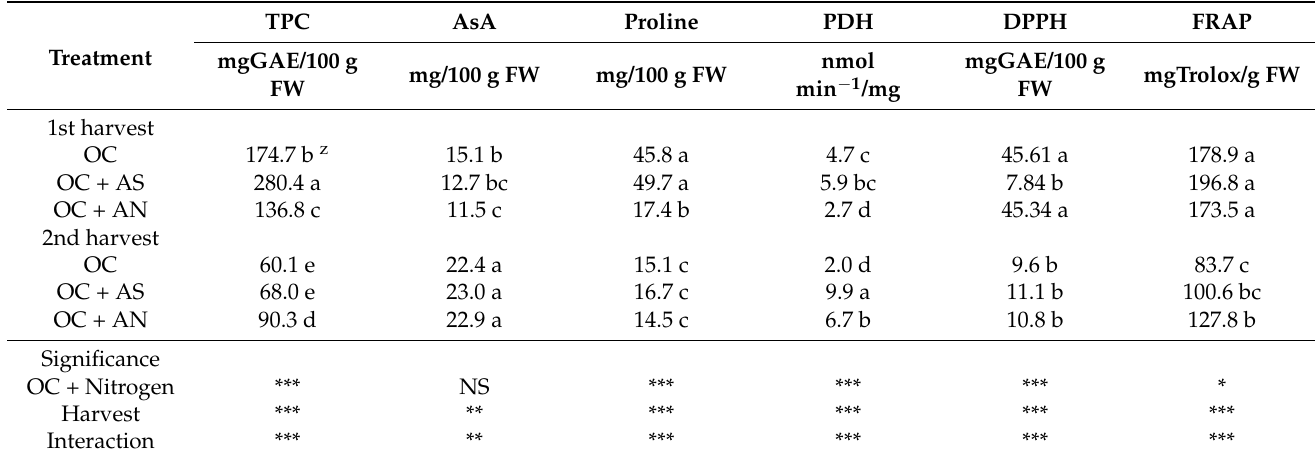
Table 5. Effect of organic compost combined with inorganic nitrogen fertigation on shoot TPC, AsA, Proline, PDH, DPPH, and